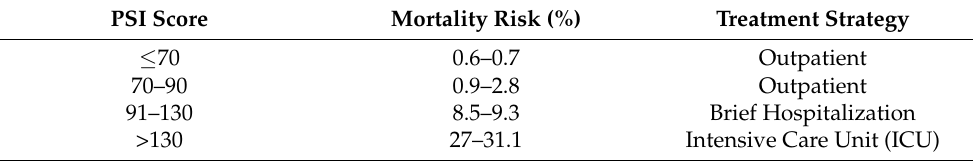
Table 1. Pneumonia severity index (PSI).